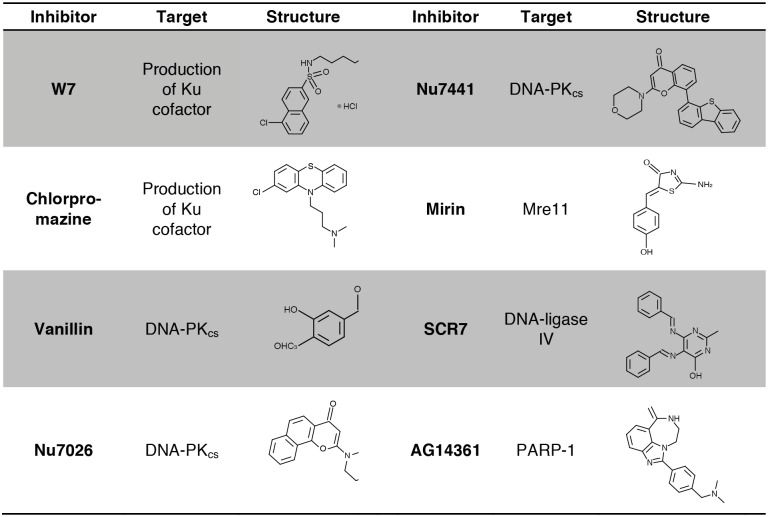
Inhibitors used in this study.Eight chemical inhibitors were employed in this study. Depicted above are their chemical structures and their targets in mammalian cell lines.